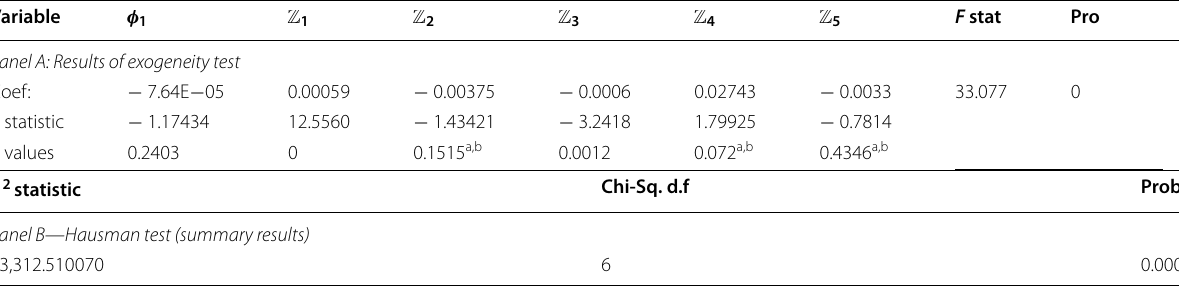
Table 4 Results of Exogeneity Test and Hausman Test